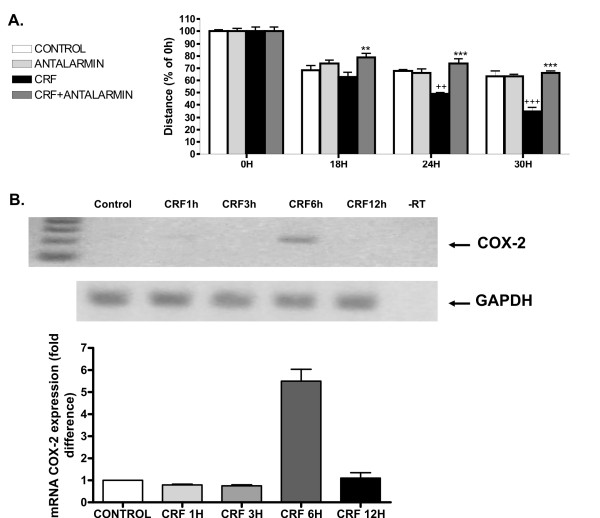
CRF promotes migration of 4T1 cells and expression of Cox-2. A. 4T1 cells were stimulated with 10-8M CRF or vehicle (control) in the presence or absence of Antalarmin and photographed at 0, 6, 12 and 24 hours after disruption of a small area of the cell layer. The remigration of the cells was quantified by measuring the distance at 3 at least different points of the gap of each image with the program Image J, and expressing the distance % of the average of the distance initially formed by the disruption (time 0). Results represent the average of three independent experiments. ++p < 0,01, +++p < 0.001 compared to control cells at the same time point; **p < 0,01; ***p < 0,001 compared to CRF-treated cells at the same time point. B. Expression of Cox-2 was measured in 4T1 stimulated cells by RT-PCR (upper panel) and real-time RT-PCR. Results represent the average of 3 independent experiments; ***p < 0,001 compared to control cells.